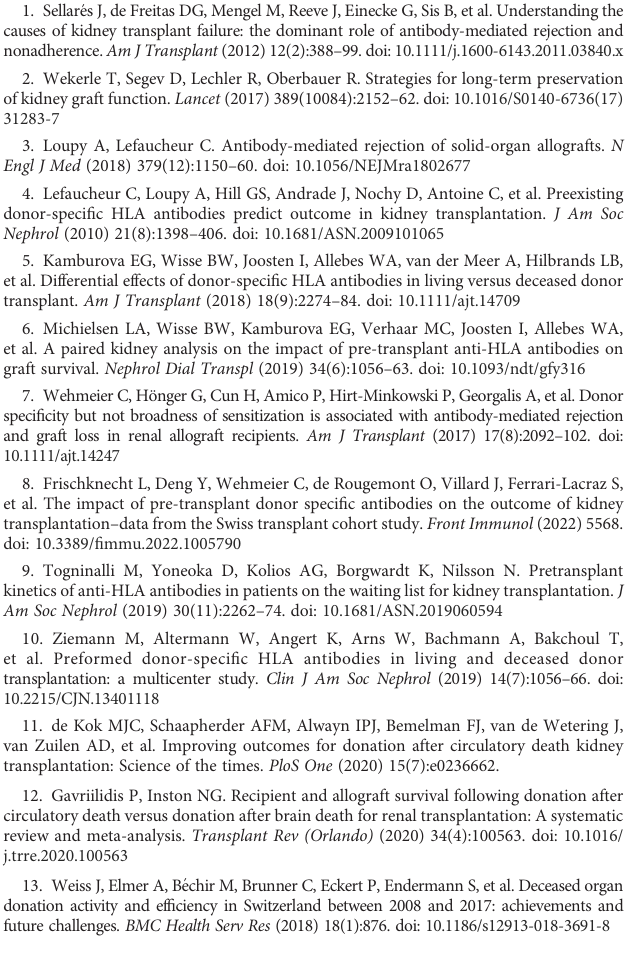
SUPPLEMENTARY FIGURE 6 Partial least squares (PLS) regression biplot forthe fi rst twocomponentsdescribing the correlation among different immunological risk factors to the development of ABMR in the different donation types. Correlation shown between ABMR and the risk factors (in blue numbers) for DBD (A) , LD (B) and DCD (C) transplants. The fi rst two axes which correspond to PLS components 1 and 2 are shown. The distance between the individual risk factors and the center indicates the strength of the correlation with each component and their alignments represent the correlation they contribute to the variation explained by each component. (OrganTx: Organ Transplantation, BlTransfusion: Blood